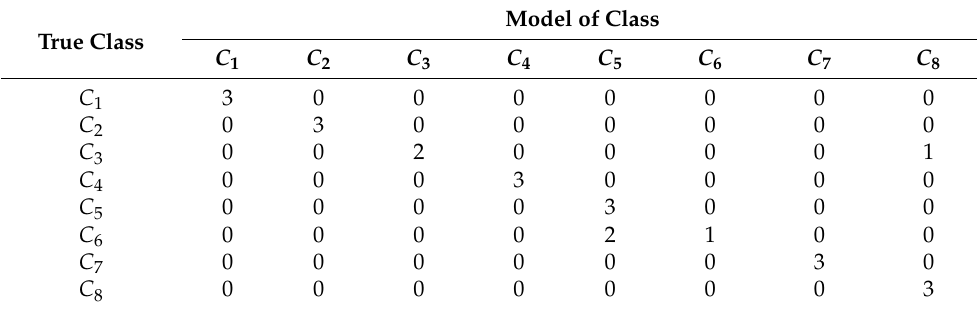
Table 4. Confusion matrix N TS for the test dataset X TS